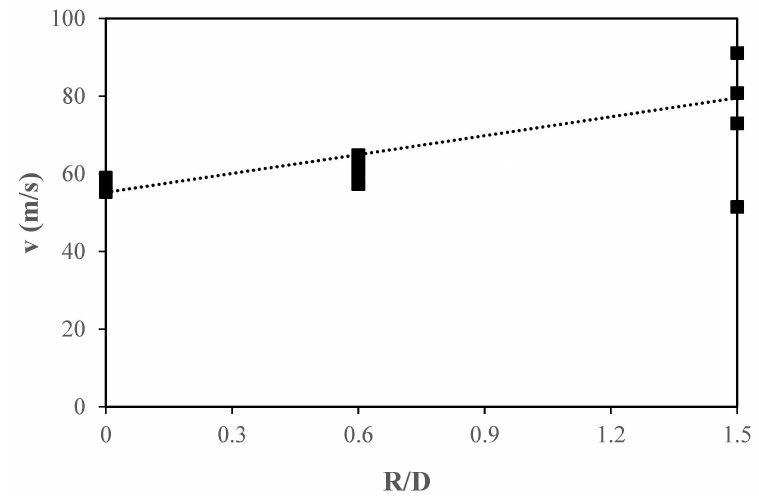
Figure 9. Influence of R/D ratio on flame speed between position 1 and 2 for aluminium dust explosions.